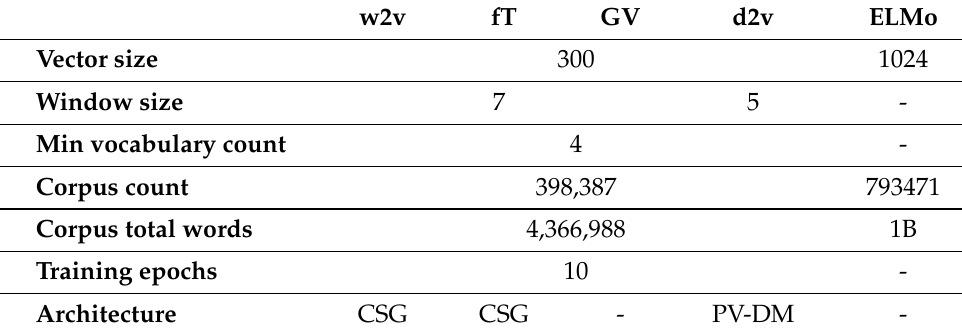
Table 3. Summary of the models’ training parameters, where applicable. w2v fT GV d2v ELMo Vector size